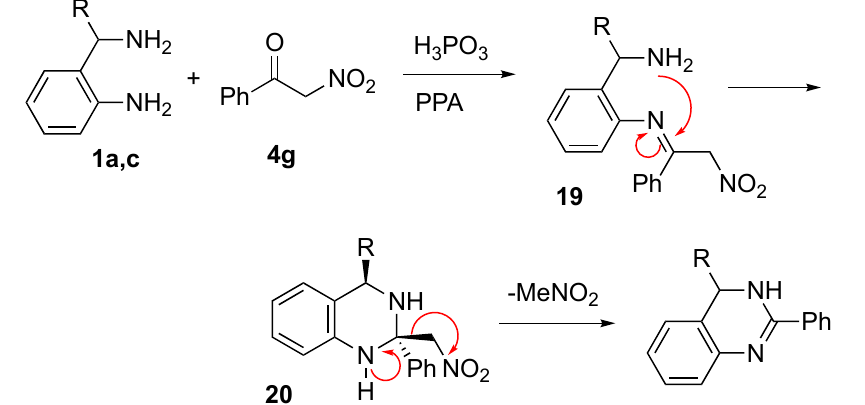
Table 1. Optimization of reaction conditions for